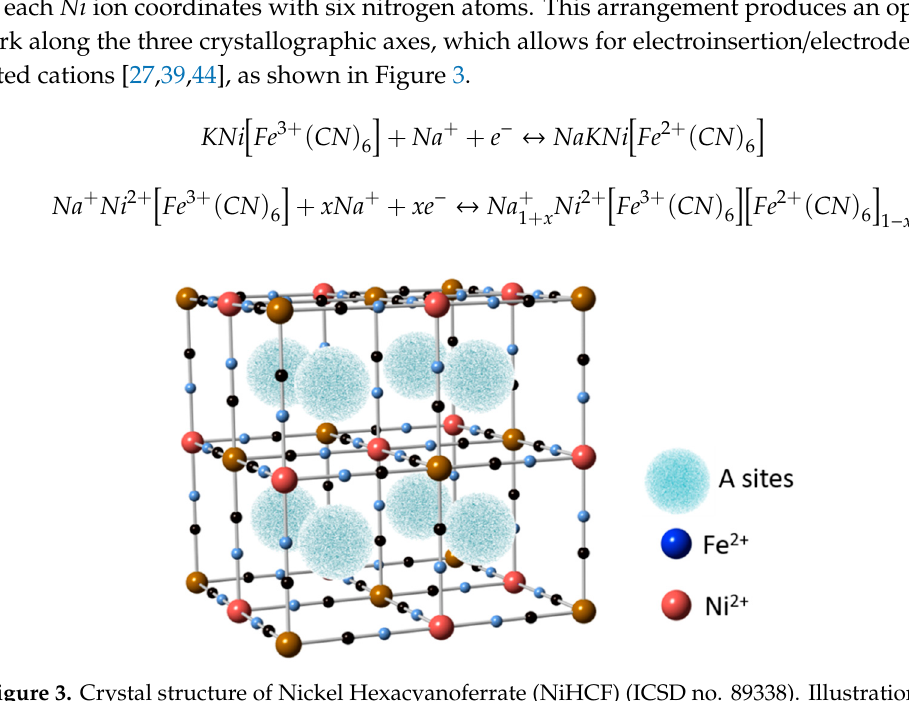
Figure 3. Crystal structure of Nickel Hexacyanoferrate (NiHCF) (ICSD no. 89338). Illustration based on [45,46].